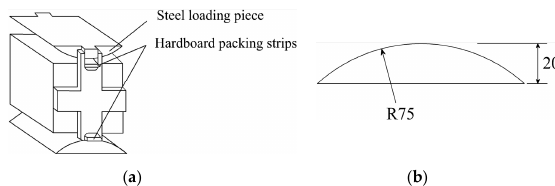
Figure 5. Illustration of cubic compressive strength test. Figure 6. Illustration of splitting tensile strength test: ( a ) Loading configuration; ( b ) Sizes of steel loading piece.